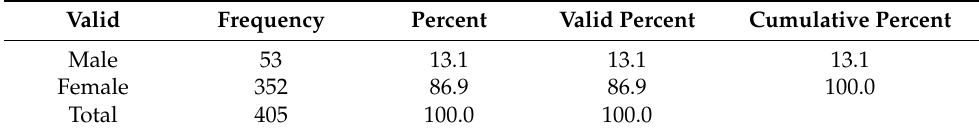
Table A1. Gender distribution.